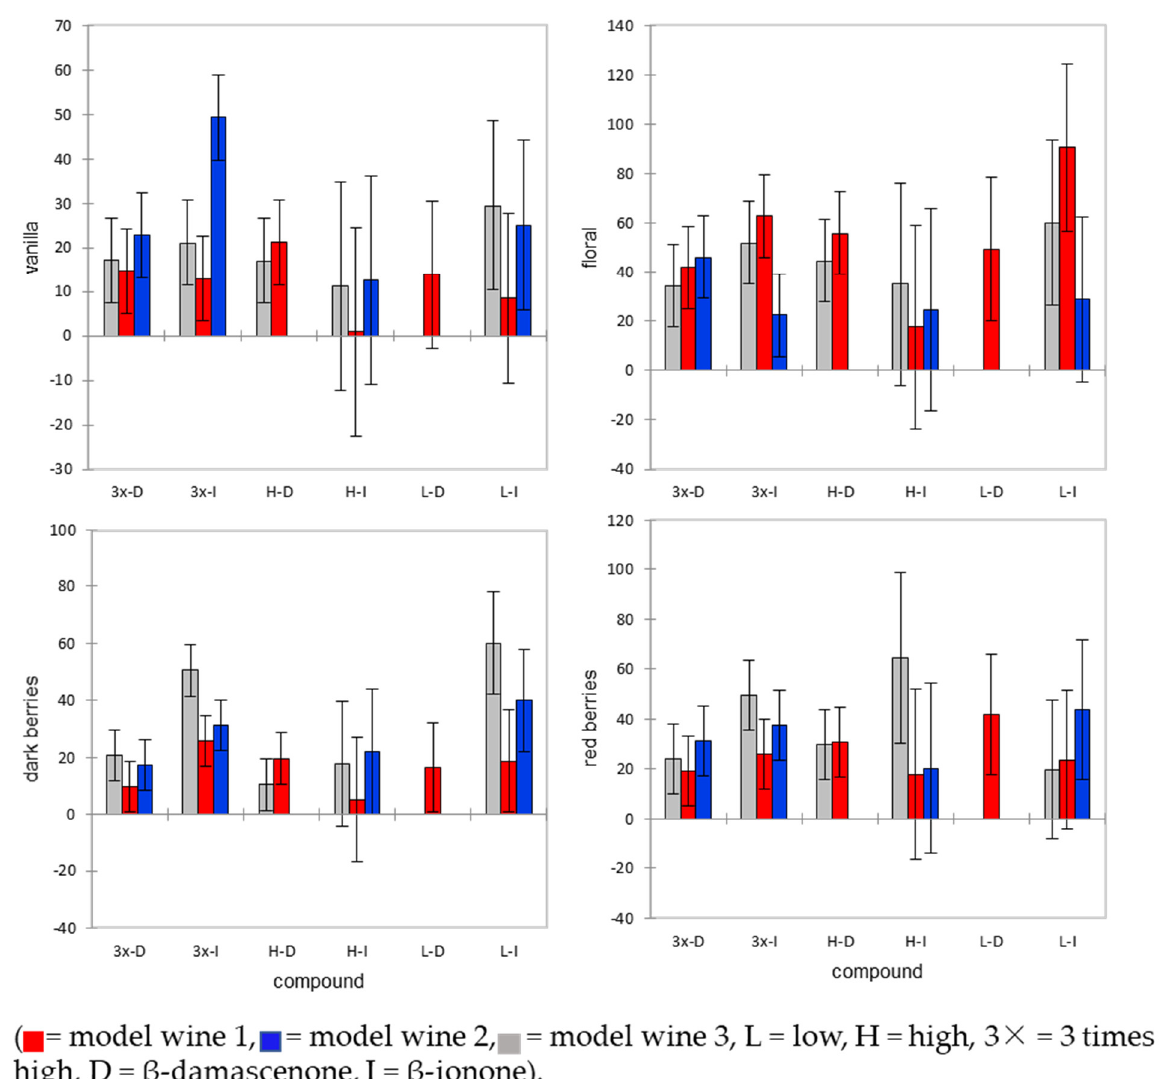
Figure 1. Means and standard deviation for each sensory attribute by compound concentration and model wine.